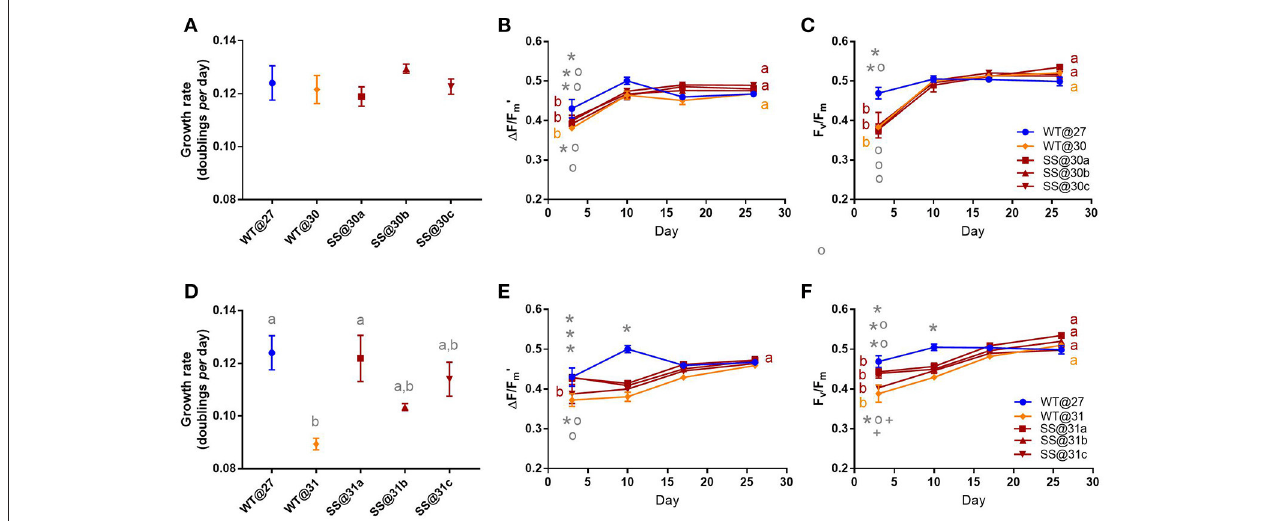
FIGURE 5 | Symbiodinium G3. Results of transplant experiment; comparison of mean ( ± SEM) growth rates (A,D) , effective quantum yields (B,E) and maximum quantum yields (C,F) between the wild-type (WT) Symbiodinium type G3 population at 27 ◦ C (WT@27), WT transferred into 30 ◦ C or 31 ◦ C (WT@30 or WT@31) and the three selected Symbiodinium G3 populations (e.g., SS@30a, b, c). Populations’ were pre-acclimated for 14 days and growth rates were measured following 17 more days and quantum yield measurements over the following 26 days. Statistically significant differences among populations at a given time point are represented by different letters (A) or symbols above/below the mean points (B,C) . Statistically significant differences over time (between D3 and D26) are represented by different letters ( B,C , Tukey’s post-hoc tests; P < 0.05), n = 3 for all means. Where error bars are not visible, they are small and hidden by the